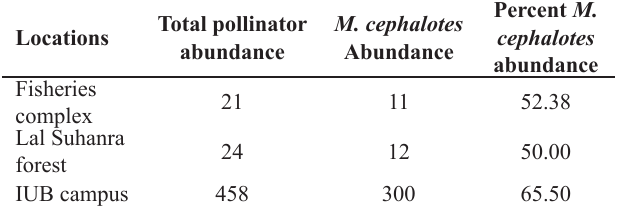
Table 1 . Relative abundance of M. cephalotes with other floral visitors at three widely isolated locations in